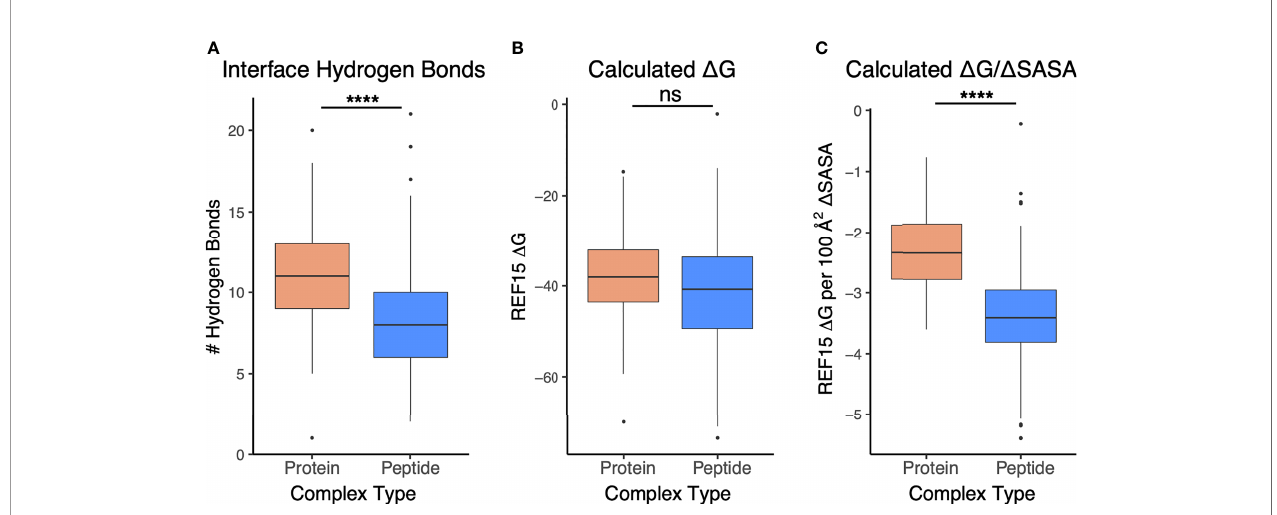
FIGURE 5 | Interface and energetic features of antibody-peptide complexes in comparison with antibody-antigen complexes. (A) Interface hydrogen bonds, (B) Calculated binding af fi nity ( D G), and (C) Calculated af fi nity per unit interface surface area are represented for antibody-antigen (N = 54) and antibody-peptide (N = 188) complex structures. Statistical signi fi cance between sets of values are from Wilcoxon rank sum test (ns: p > 0.05; ****: p ≤ 0.0001).